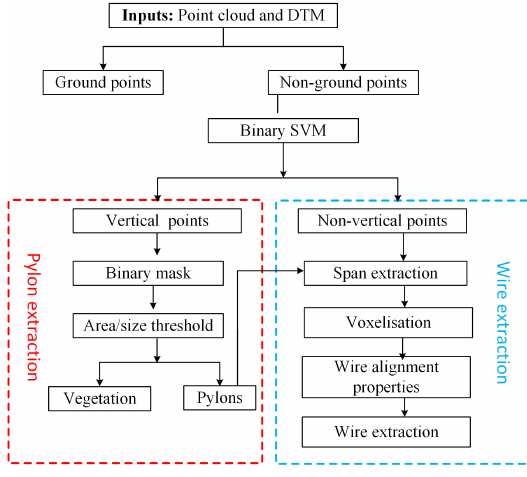
Figure 1. The work flow of the proposed